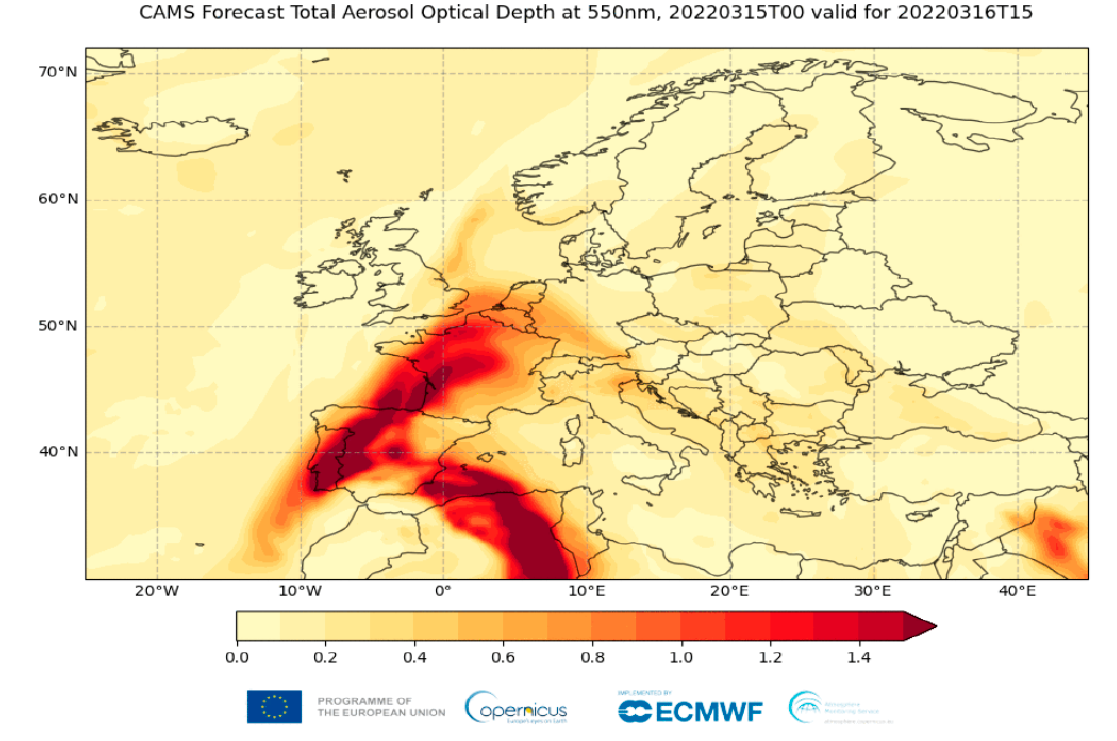
Figure 2. Forecast of movement of dust from Sahara over Europe on 15 to 16 March 2022. Source: Copernicus Atmospheric Monitoring Service (https://atmosphere.copernicus.eu accessed on 23 June